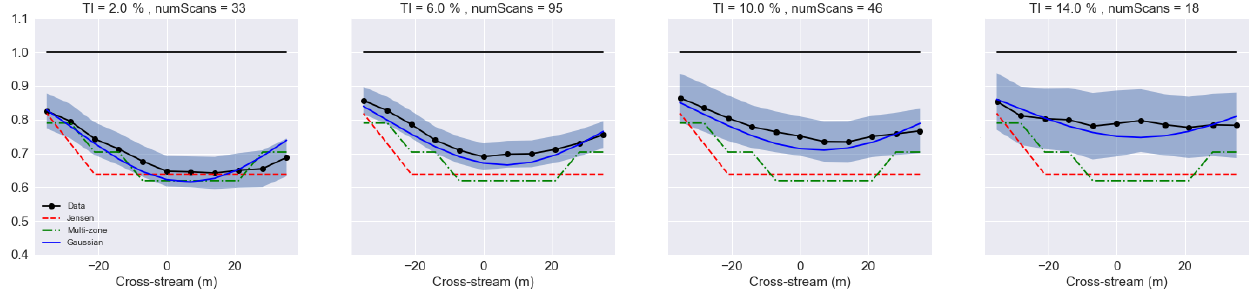
Figure 4. Velocity deficit at 180.95m downstream computed using lidar data, the Gaussian wake model, multi-zone wake model, and the Jensen wake model under different turbulence intensity conditions.